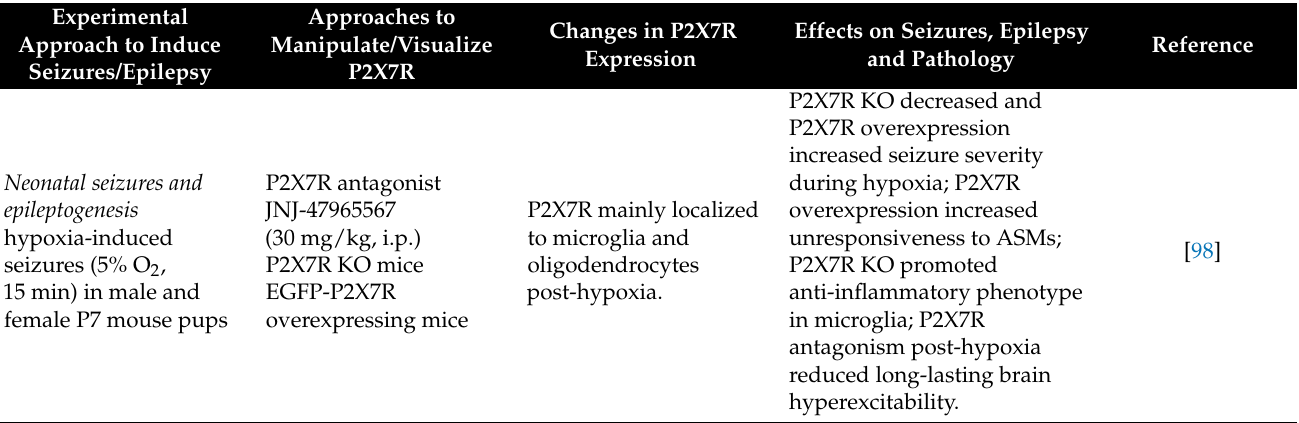
Table 1. Selected studies investigating the therapeutic potential of targeting P2X7R during seizures and